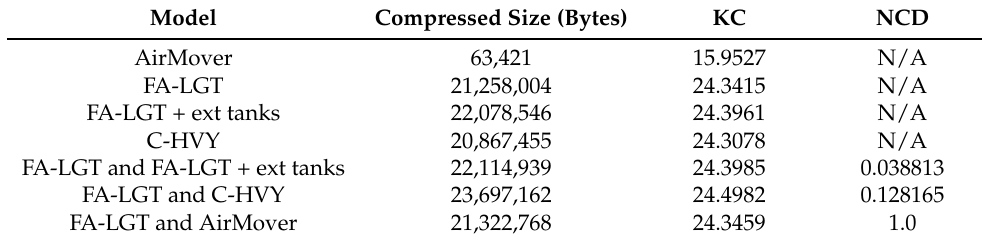
Table 5. Compressed archive file size and normalized compression distance